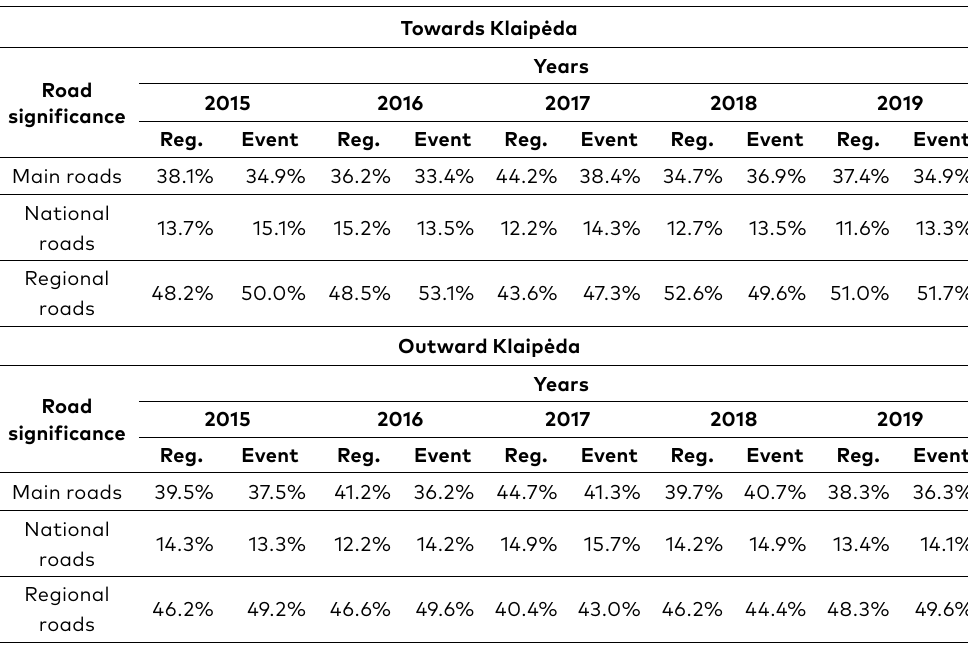
Table 4. Differences between traffic volume towards and outward Klaipėda during “The Sea Festival” and a regular weekend considering road significance Towards